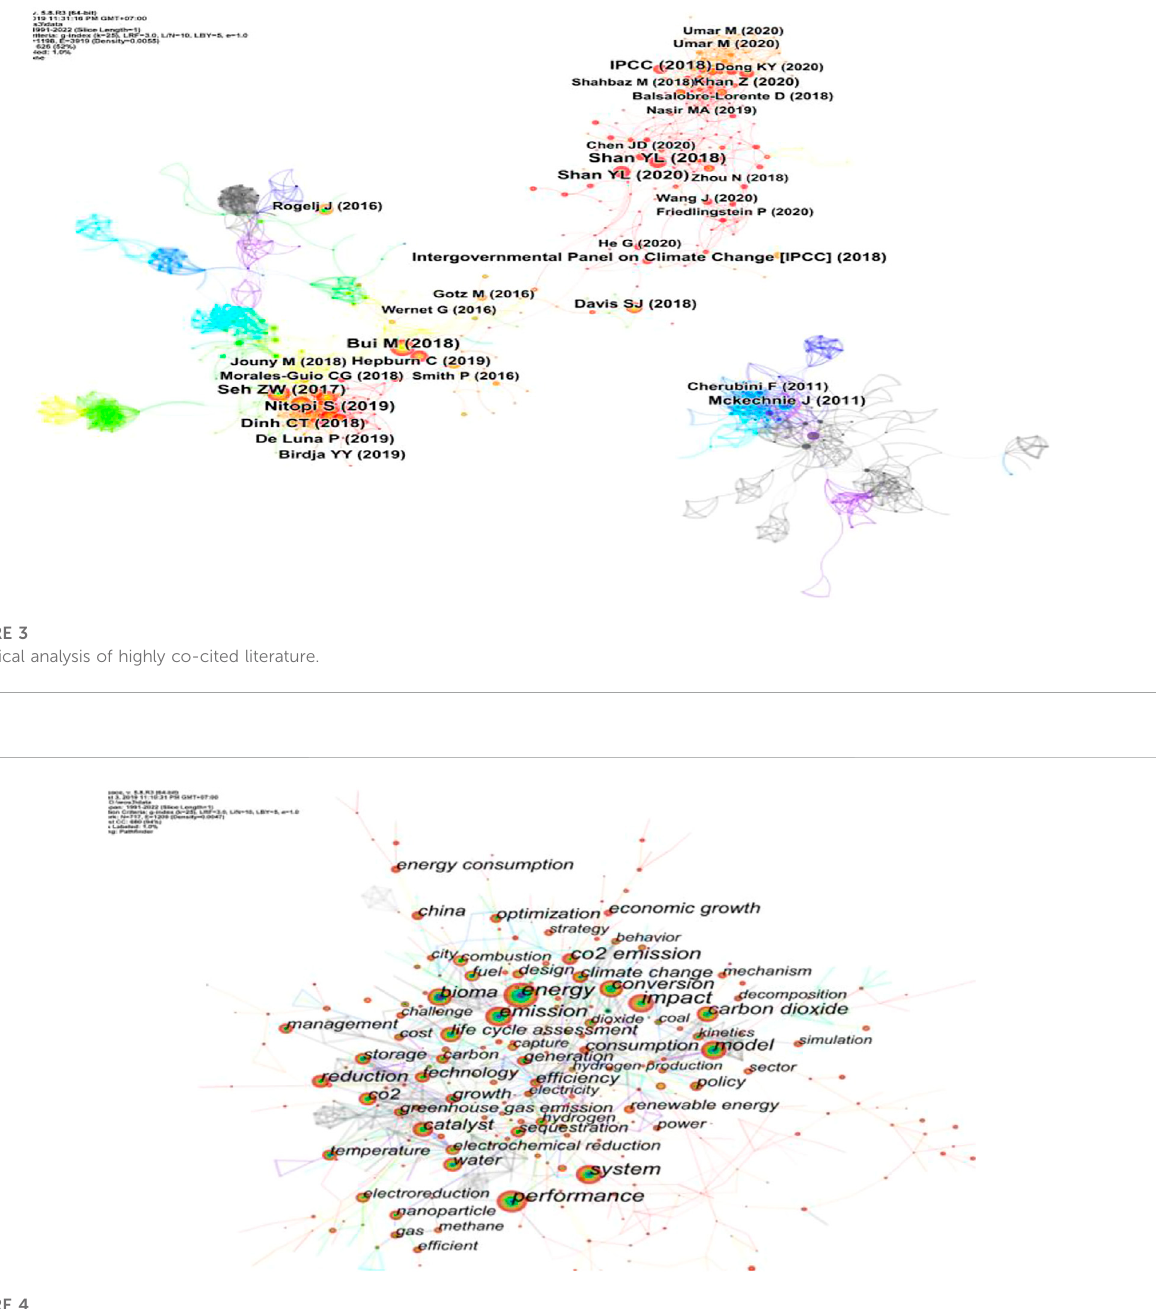
(0.14), and biodiesel (0.13). The current foreign carbon peak